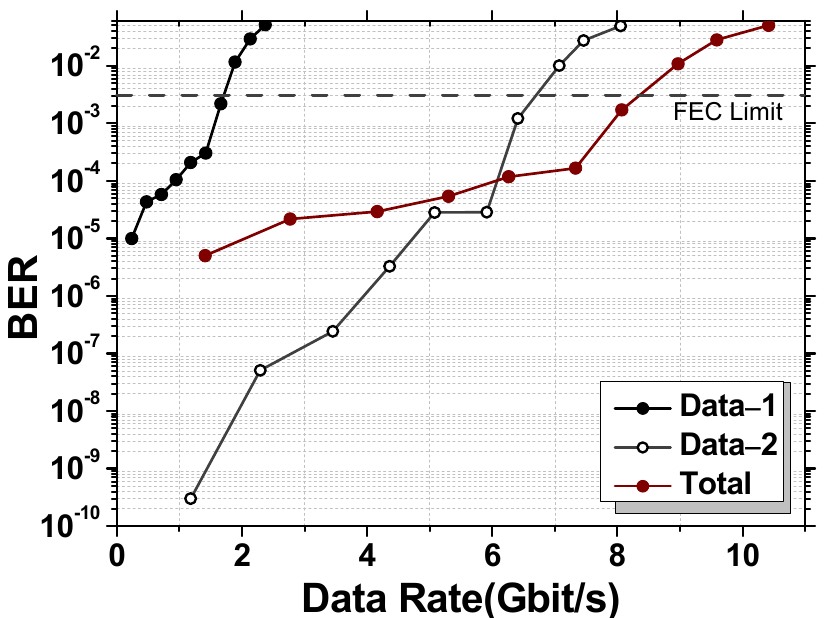
Figure 5. Measured BER curves of the two individual signals and the PowDM signal.